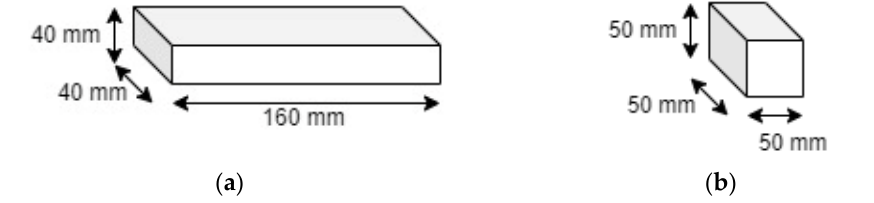
Figure 1. ( a ) Specimen dimensions for compression tests; ( b ) Specimen dimensions for water absorption tests by immersion.